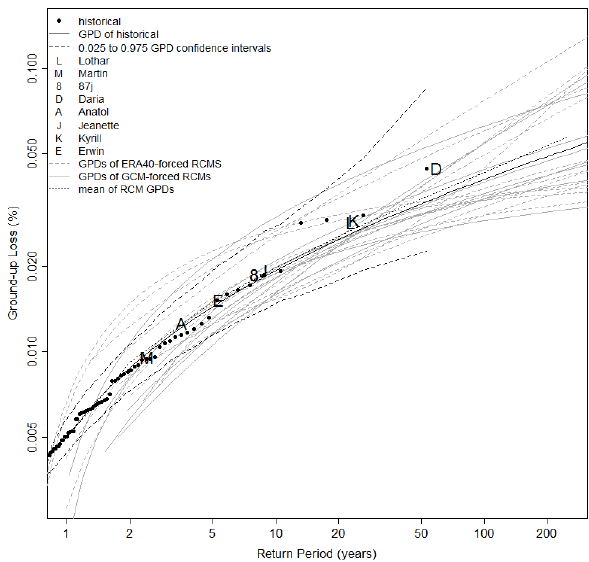
Fig. 6 As for Fig. 5 but using only the 70 largest storms from each RCM. Fig. 6. As for Fig. 5 but using only the 70 largest storms from each